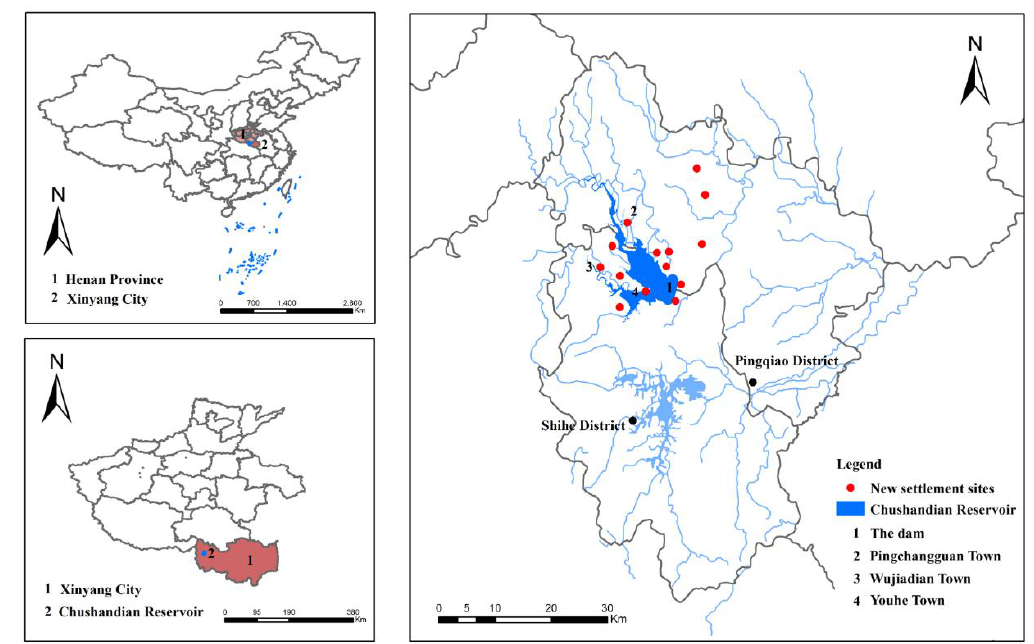
Figure 3. Location of the study area. Source: designed by the